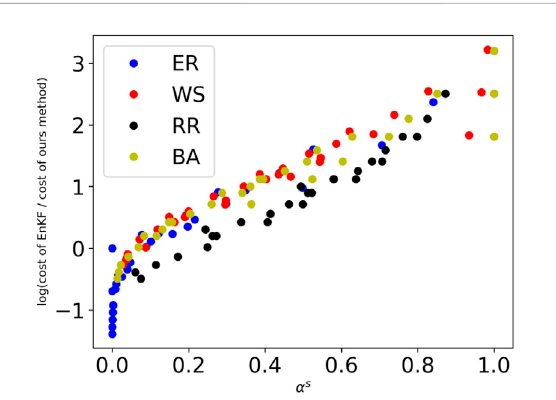
FIGURE 4 The logarithm of the ratio of communication cost between EnKF and our proposed method with different α s . As the sparsity of the network increases (i.e., α s > 0.1), the communication cost of EnKF is much more than the Particle Network